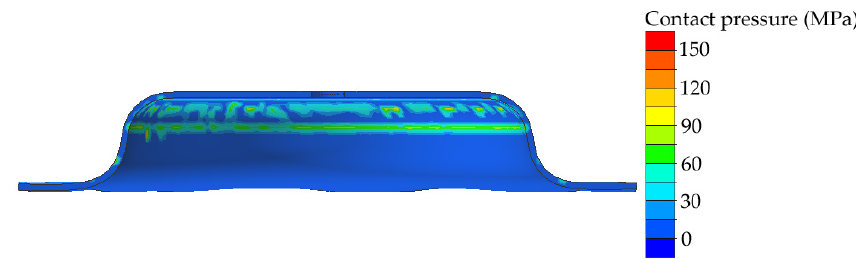
Figure 14. Contour levels of the developed contact pressure during workpiece forming for the X12Cr13 alloy simulated numerically (cross-sectional view).